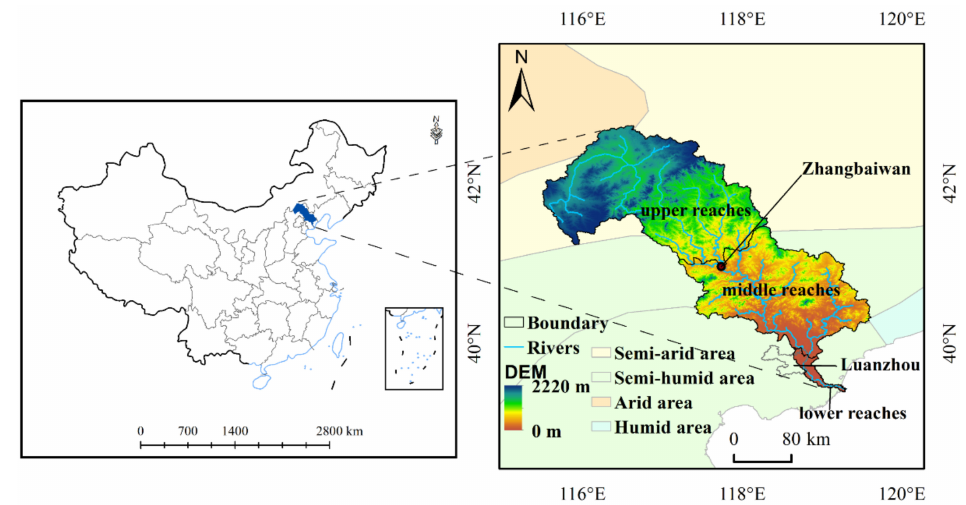
Figure 1. Geographic location of the study